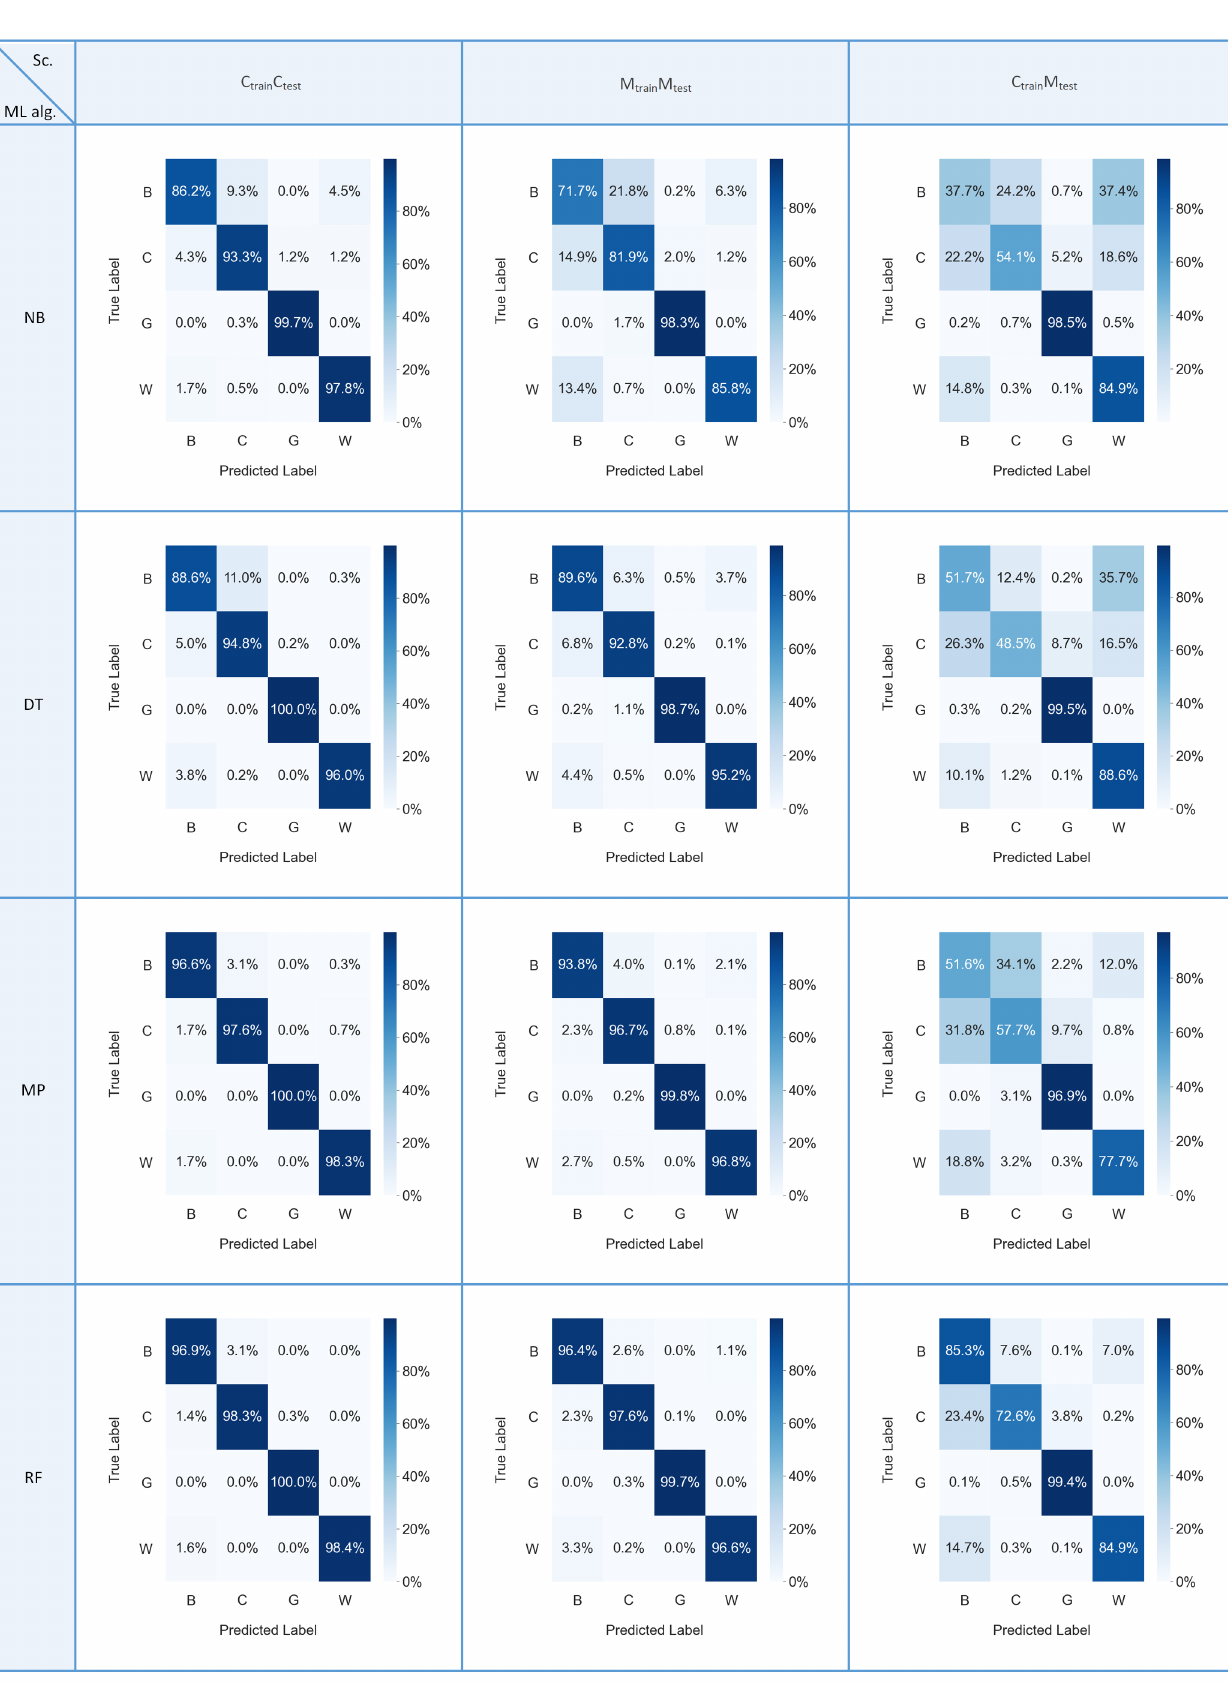
Figure 6. Confusion matrices for different ML algorithms and scenarios, (B—brick, C—concrete, G—glass,